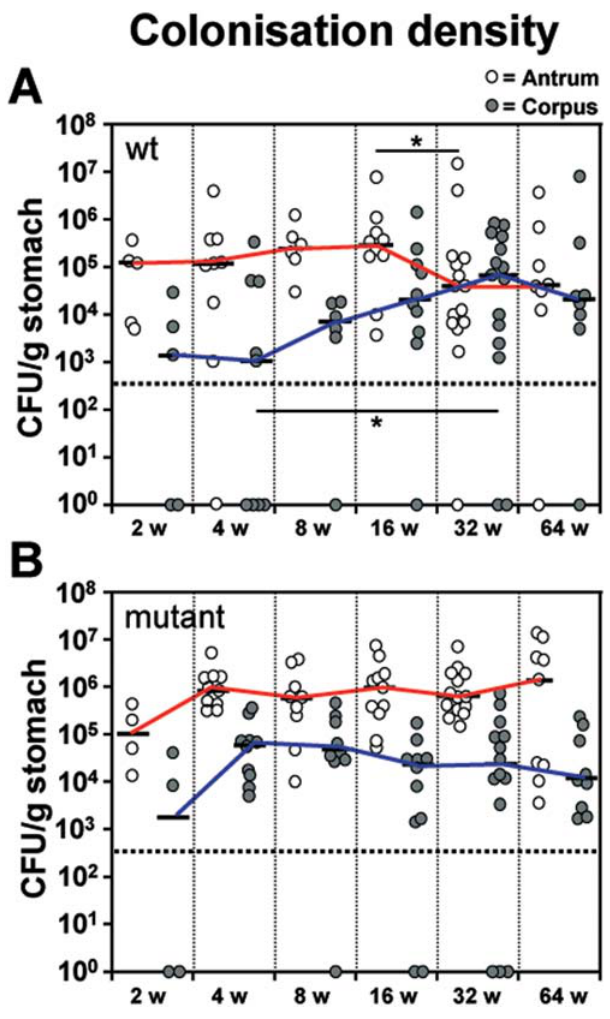
Figure 1. Increased Helicobacter pylori B128 WT colonization density shown in corpus mucosa over the time course experiment. Colonization density of antral (white circles) and corpus (gray circles) mucosa in orally challenged gerbils with H. pylori B128 WT (A) and B128 D cag Y (B) isogenic mutant strain after 2, 4, 8, 16, 32, and 64 weeks of infection. The interpolated lines connect the medians of the respective time-points. The detection limit was , 5 6 10 2 colony-forming units (CFU) per gram of stomach (horizontal dotted line). Gastric tissue specimens without H.pylori reisolation are shown as null. (*p , 0.05).